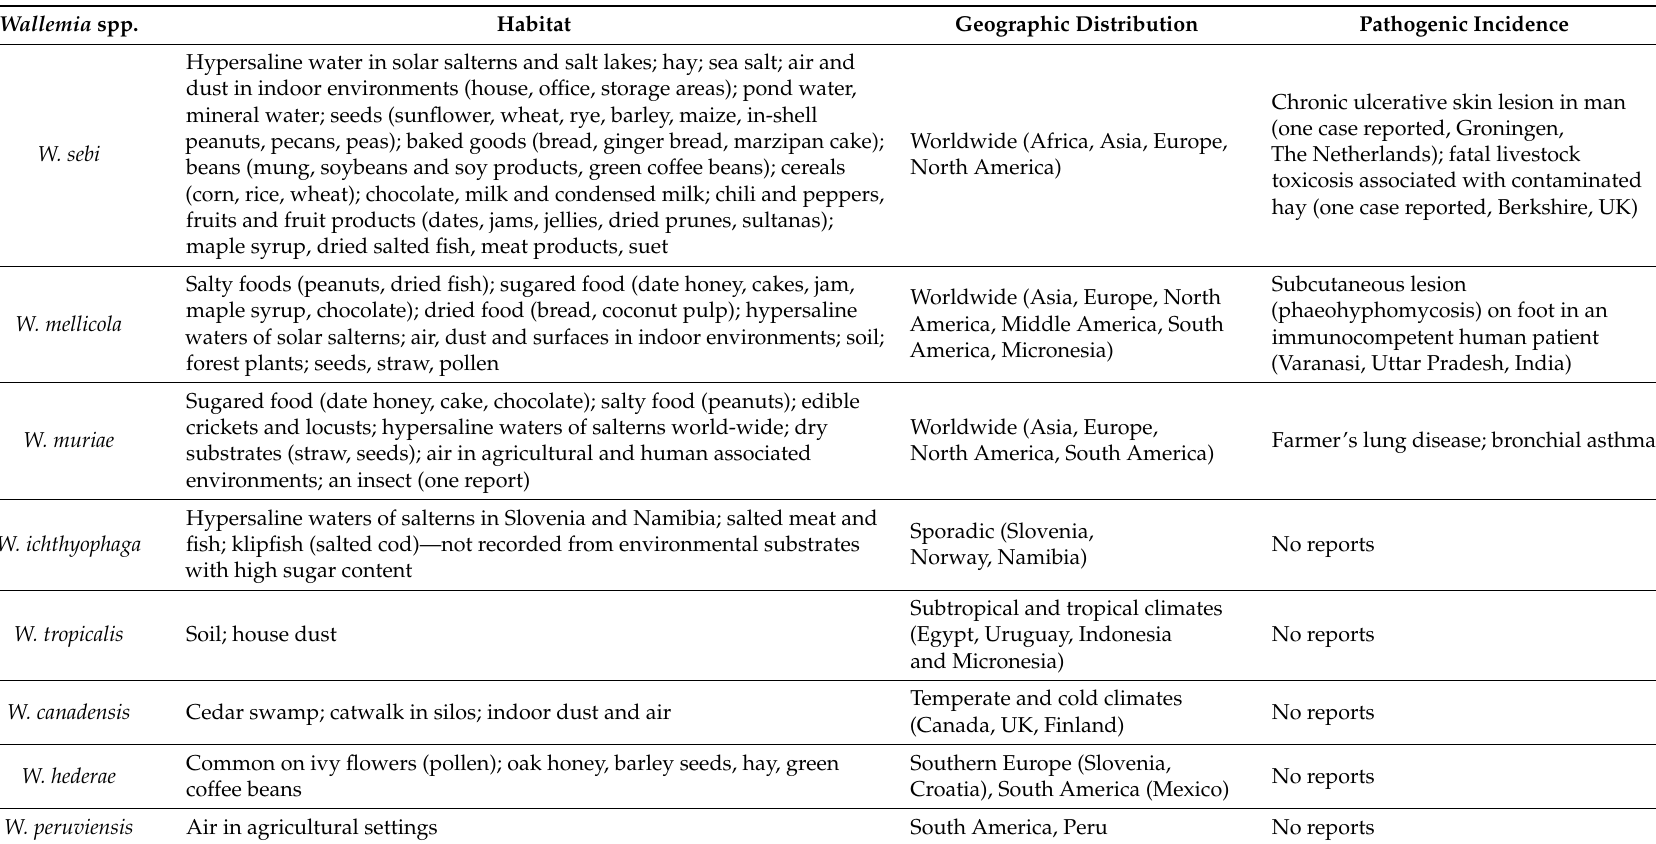
Table 1. Known habitats, geographic distributions, and pathogenic potentials of the eight members of the genus Wallemia . Adapted after [5,6,8,9,13,23–28]. Wallemia